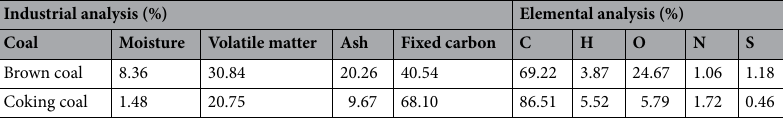
Table 1. Industrial analysis and elemental analysis of raw